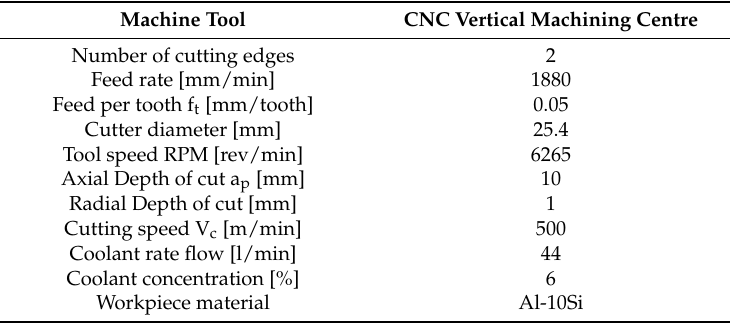
Table 1. Cutting conditions used during face milling of Al-10Si alloy with DLC- and DLC-WS 2 -coated